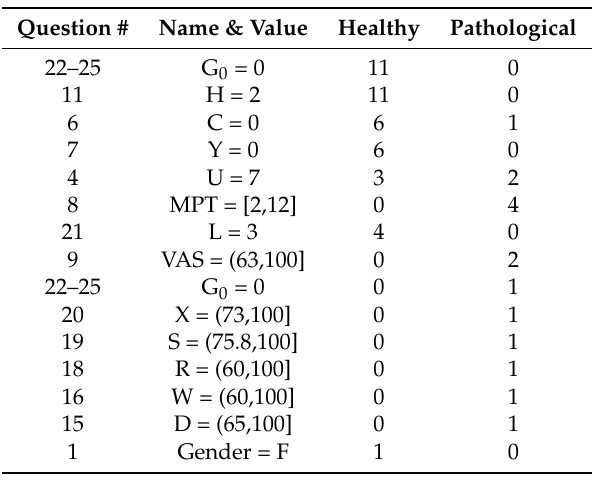
Table 2. Rule coverage for mined antecedent items. Absolute frequency (gravity), as the number of rules the specific response participates in, is in “Healthy” and “Pathological”